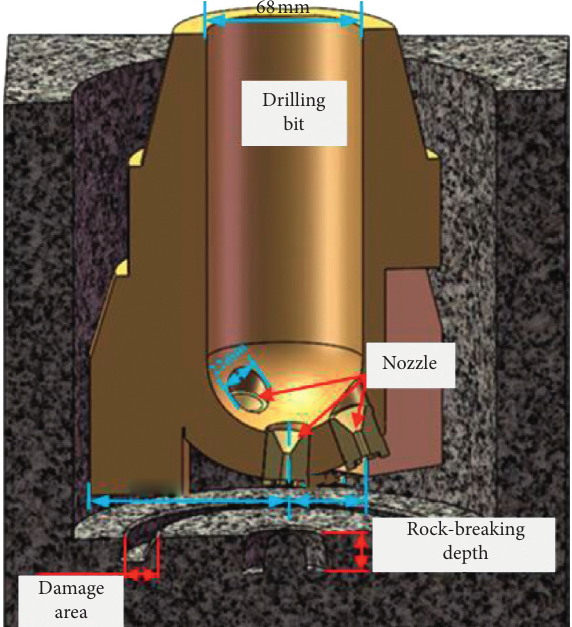
Figure 3: The measurement of rock-breaking depth and damage